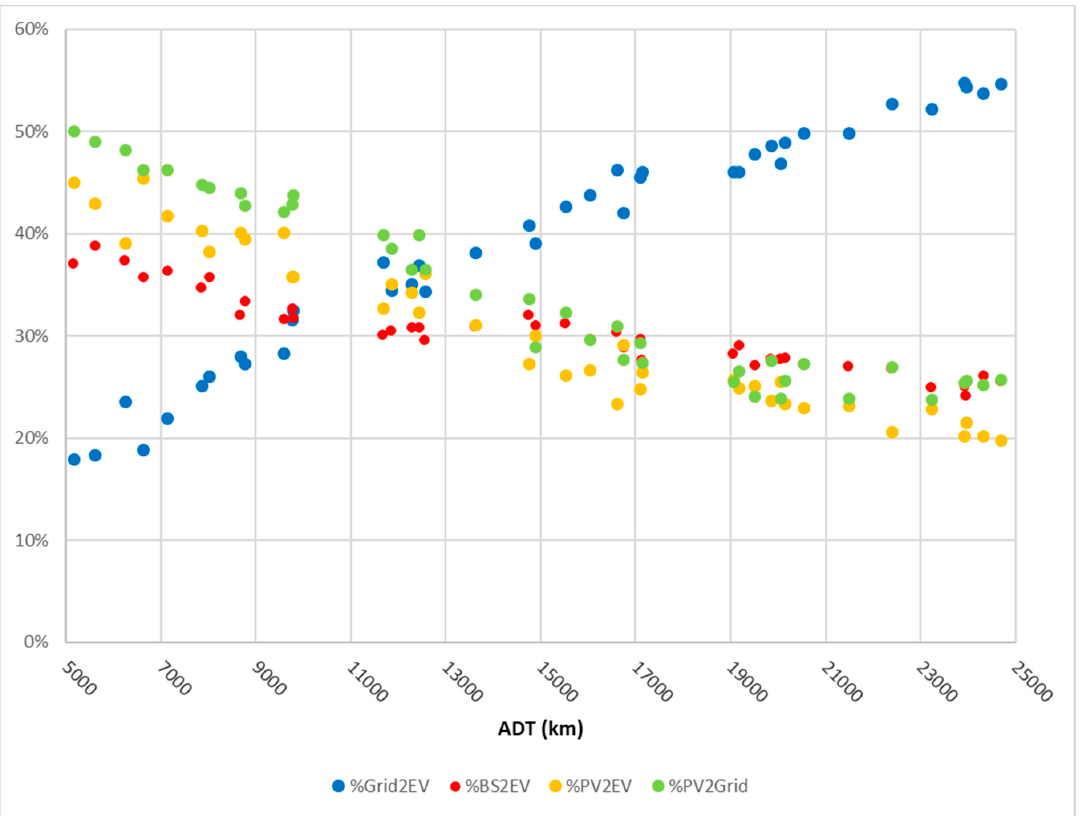
Figure 6. Energy source used to charge the EV and electricity discharged into the electrical grid with varying ADT in Scenario 1.